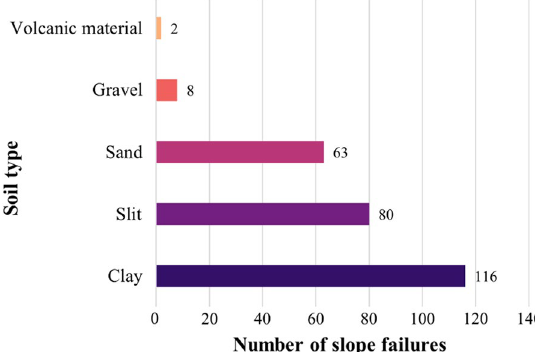
Fig. 18 Number of slope failures associated with different sediment types (modified from Hance